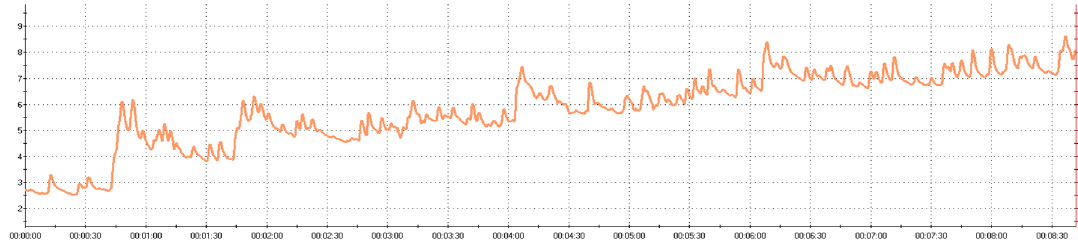
Figure 10. Bio-data—Subject’s skin conductance during the experiment session.